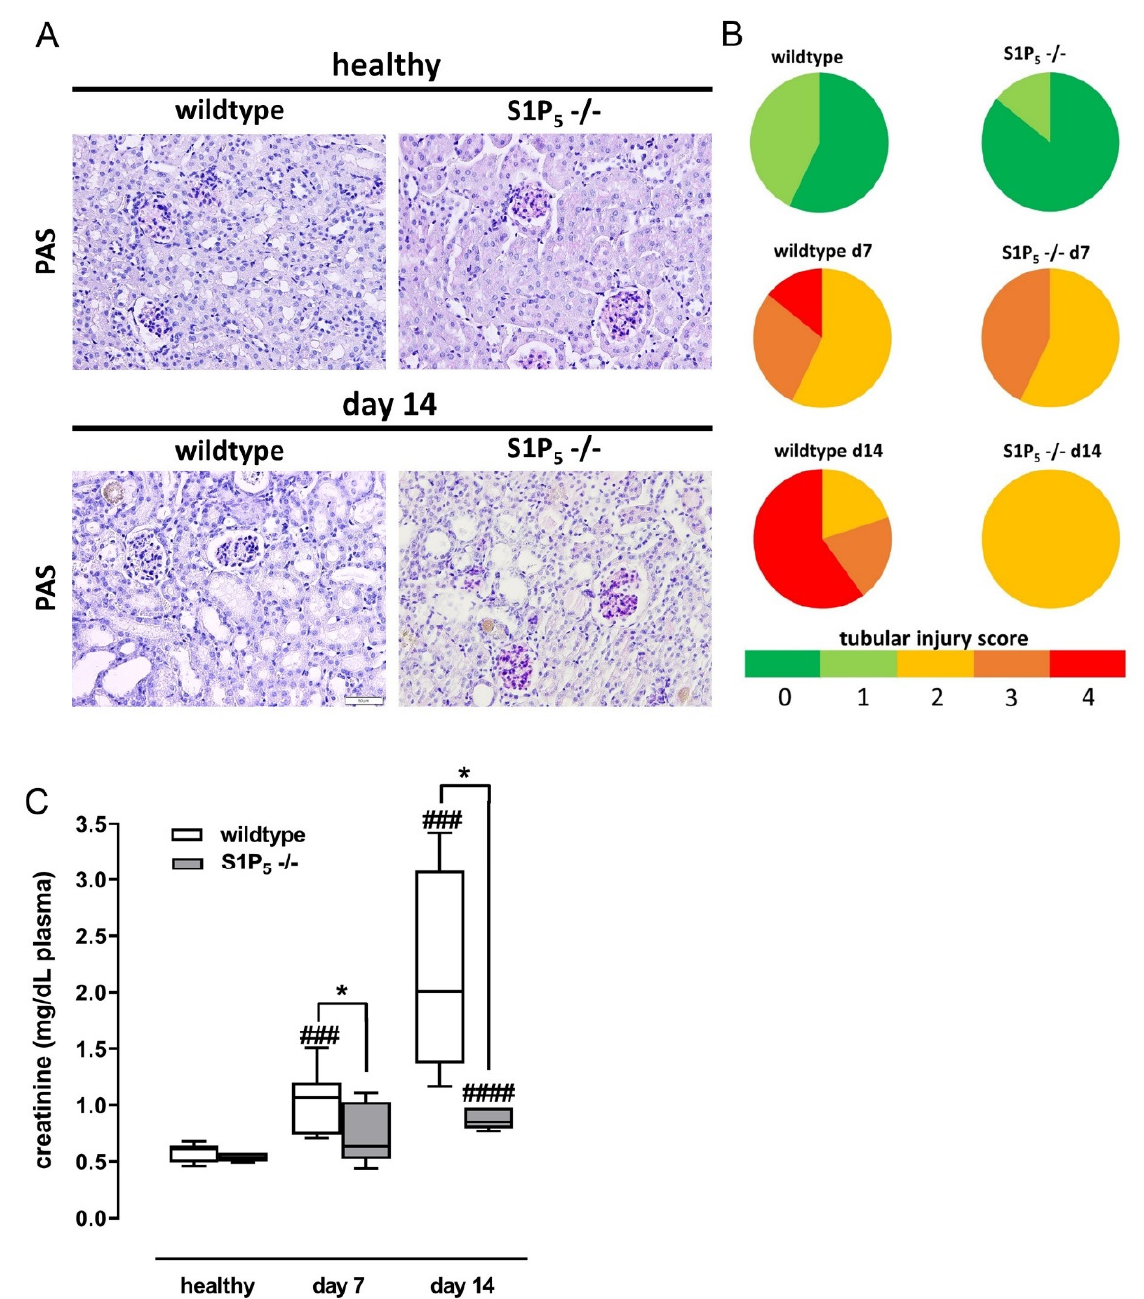
Figure 2. Assessment of renal tissue damage and plasma creatinine levels of healthy mice and mice fed with an adenine-rich diet for the indicated time periods. ( A ) Paraffin-embedded kidney cortex sections were subjected to PAS staining. The images reveal glomeruli (dark pink), tubular dilatations (big gaps), and crystal depositions (amber color). ( B ) Tissue damage of wild-type and S1P 5 knockout mice (S1P 5-/- ) without (healthy) and with adenine-rich diet for 7 days and 14 days were evaluated by three blinded observers according to the following tubular injury score: 0/dark green: 0%; 1/light green: ≤ 25%; 2/yellow: >25% to 50%; 3/orange: ≥ 50% to <75%; 4/red: ≥ 75% of the area displayed tubular damage. ( C ) Creatinine levels were measured in plasma samples (EDTA) by ELISA as described in the Materials and Methods Section. Data are shown as box plots with a line at the median and whiskers from minimum to maximum value; * p ≤ 0.05 as indicated; ### p ≤ 0.001, #### p ≤ 0.0001 as compared to the respective healthy controls.